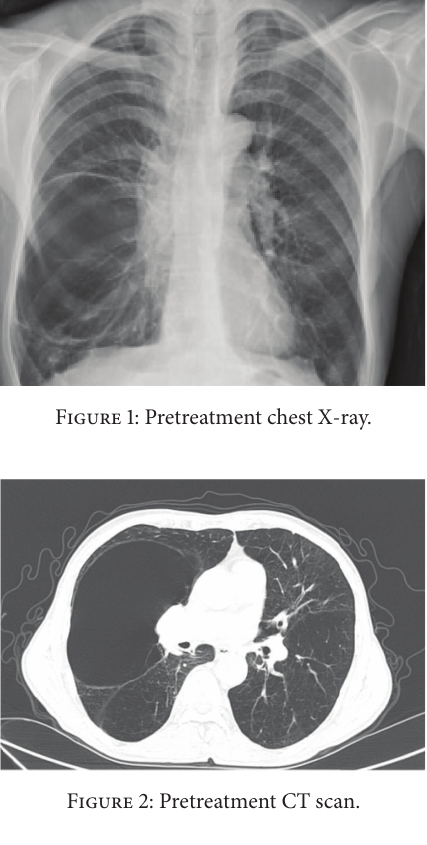
Figure 2: Pretreatment CT scan.